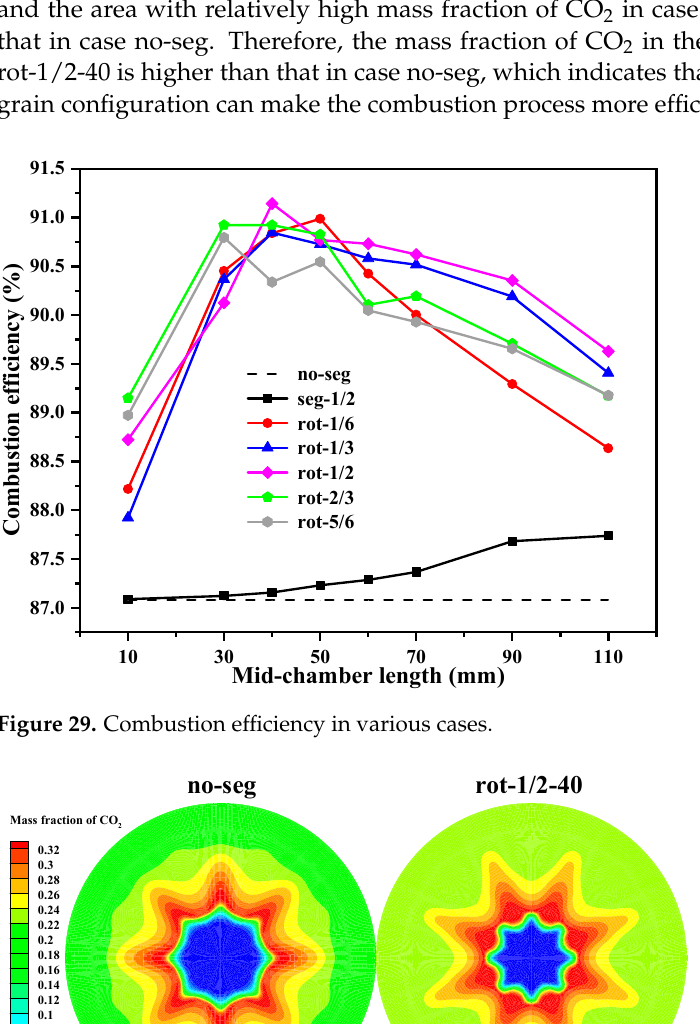
Figure 31. The history of combustion chamber pressure, thrust, average fuel regression rate, and combustion efficiency was obtained, and full-time motor performances are